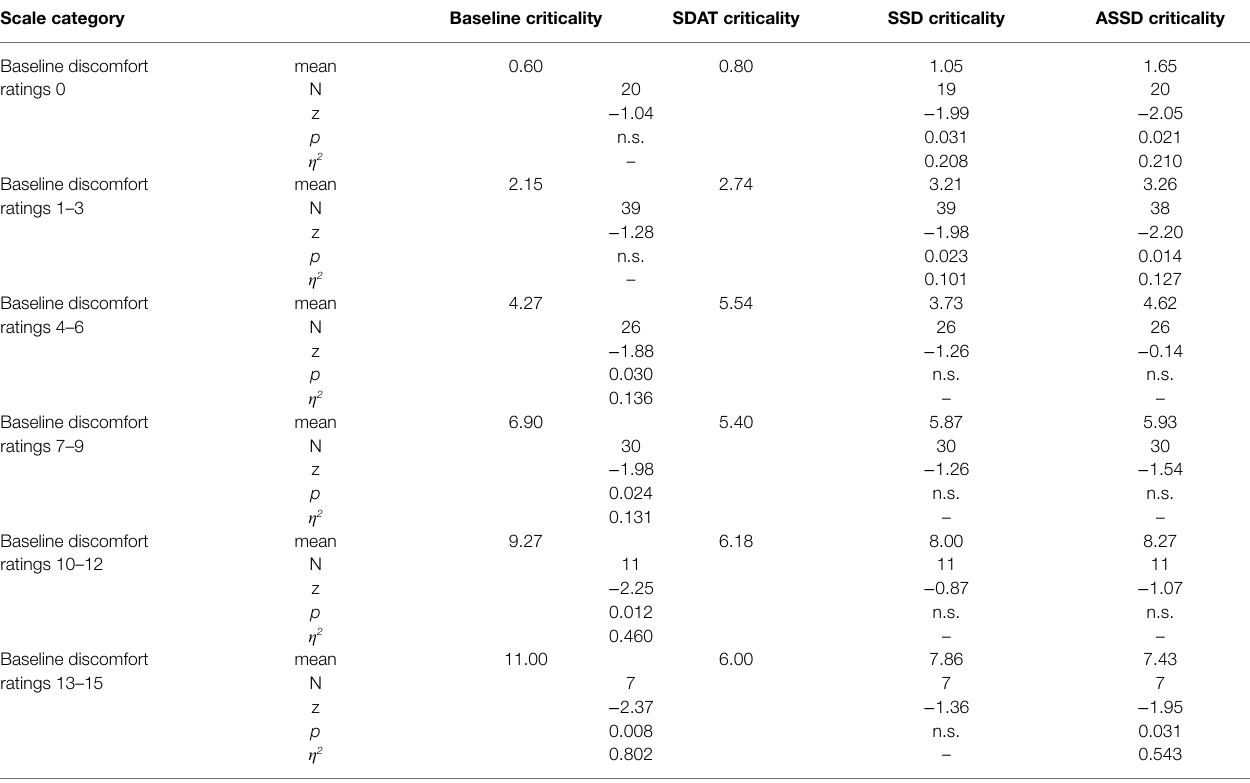
TABLE 4 | Exact Wilcoxon-Tests (one-sided) for criticality rating differences between assisted and non-assisted rides by assistant system and by scale category of the baseline discomfort ratings. Scale